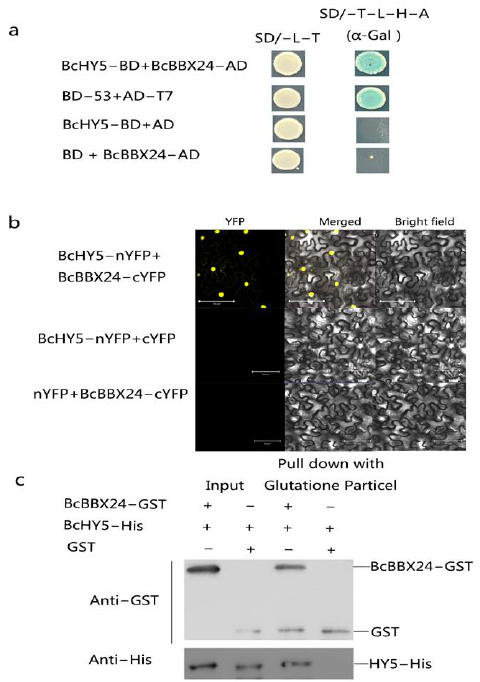
Figure 4. BcHY5 interacts with BcBBX24. ( a ) Interaction between BcHY5 and BcBBX24 in the yeast two-hybrid assay. The full-length BcHY5 was fused with the GAL4 DNA-binding domain (BD) and GAL4 activation domain (AD) fusions of BcBBX24. The yeast cells were grown on SD-TL and SD-TLHA with added α -Gal. ( b ) Bimolecular fluorescence complementation (BiFC) assay. BcHY5 was fused with the N-terminal (nYFP) portion of YFP, while BcBBX24 was fused with the C-terminal (cYFP) portion of YFP. Different constructs were co-transformed into tobacco leaves, and fluorescence was observed under a confocal microscope. YFP, yellow fluorescent protein. Bars, 100 μm and 50 μm. ( c ) GST pull-down assay. GST-tagged BcBBX24 was co-incubated with His-tagged BcHY5, immunoprecipitated with GST resin, and detected using anti-His antibody and anti-GST antibody.